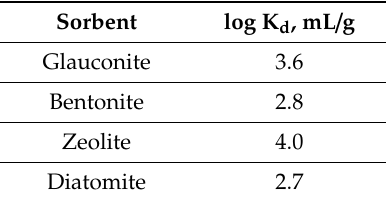
Table 5. K d values for 137 Cs sorption onto the studied sorbents at pH = 7.0 ± 0.2 in 0.01M NaClO 4